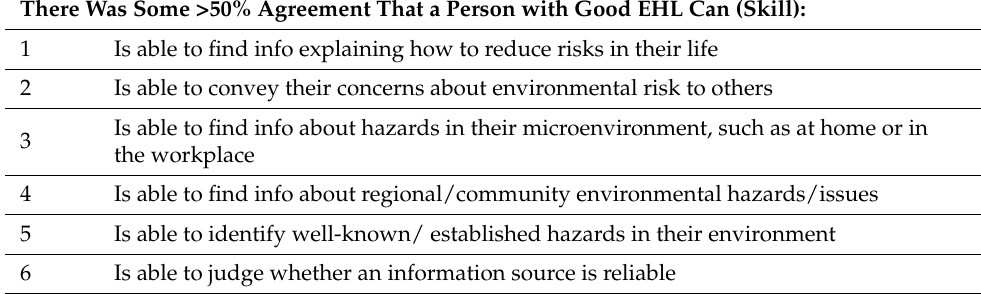
Table 4. Skill Items chosen for the EHL